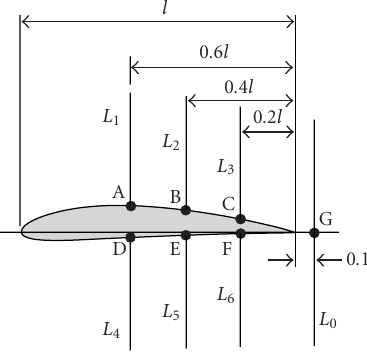
Figure 7: Lines and points for air volume fraction around hydrofoil.